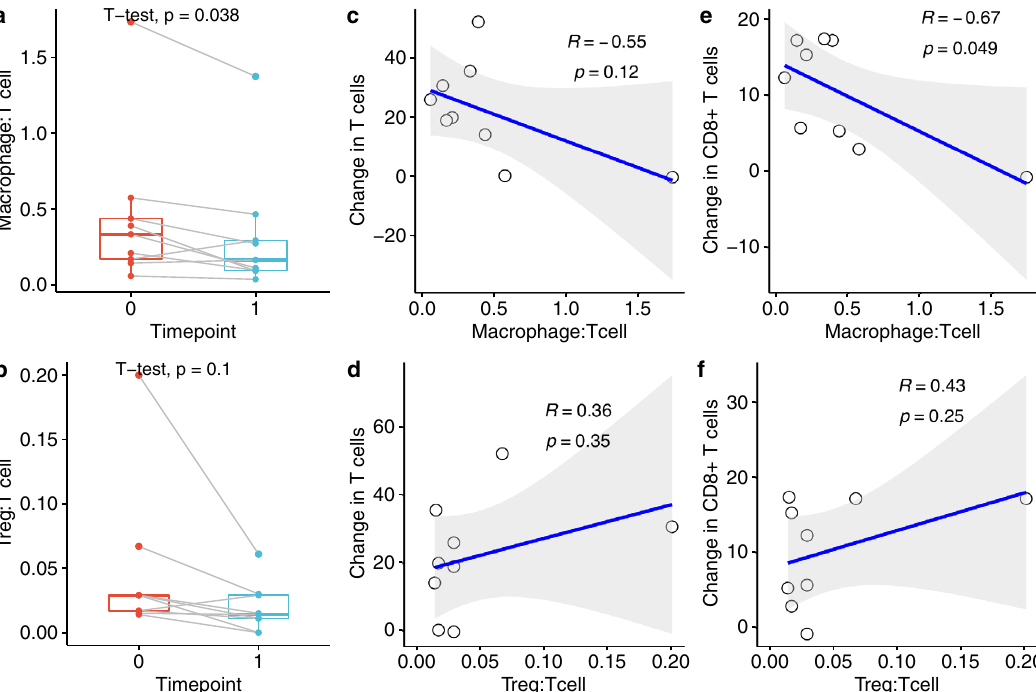
Fig. 5 Changes in macrophage:T cell and Treg:T cell ratios in response to intralesional anti-PD-1 therapy. a , b Comparison of pre-therapy (timepoint 0) and post-therapy (timepoint 1) macrophage:T cell ratio ( a ) and Treg:T cell ratio ( b ). The bounds of each box represent the interquartile range (IQR). The horizontal line within a box is the median. Whiskers extend to the largest and smallest values no further than 1.5*IQR. Outlying points beyond the ends of the whiskers are plotted individually. Each pair of connected points represents one patient ’ s data; p -values are derived from paired t -tests. c – f correlations between macrophage:T cell and Treg:T cell ratios and the change, pre-therapy versus post-therapy, in T cells ( c , d ) and in CD8 + T cells ( e , f ); R and p from Pearson ’ s correlation. Gray shaded area represents 95% con fi dence region.